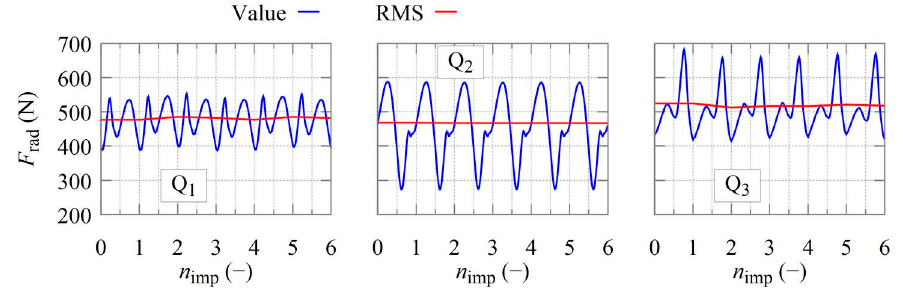
Figure 5. Radial force fluctuation during six revolutions of the impeller for flow rates Q 1 , Q 2 and Q 3 .